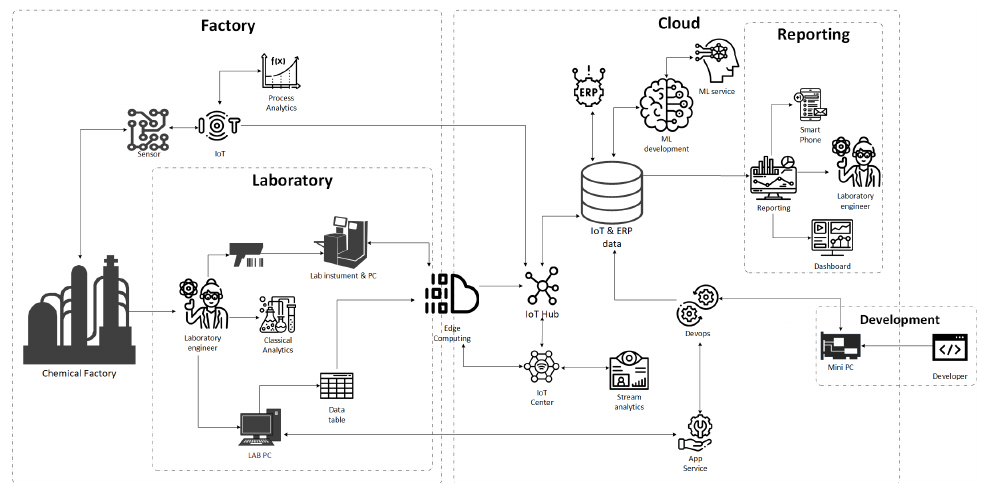
Figure 5. Architecture supporting measurements of the quality control in chemical processes. The dashed lines indicate the boundaries of the two main parts (factory, cloud) and three sub-parts (laboratory, reporting, development), the edge-computing device connects the cloud and onsite